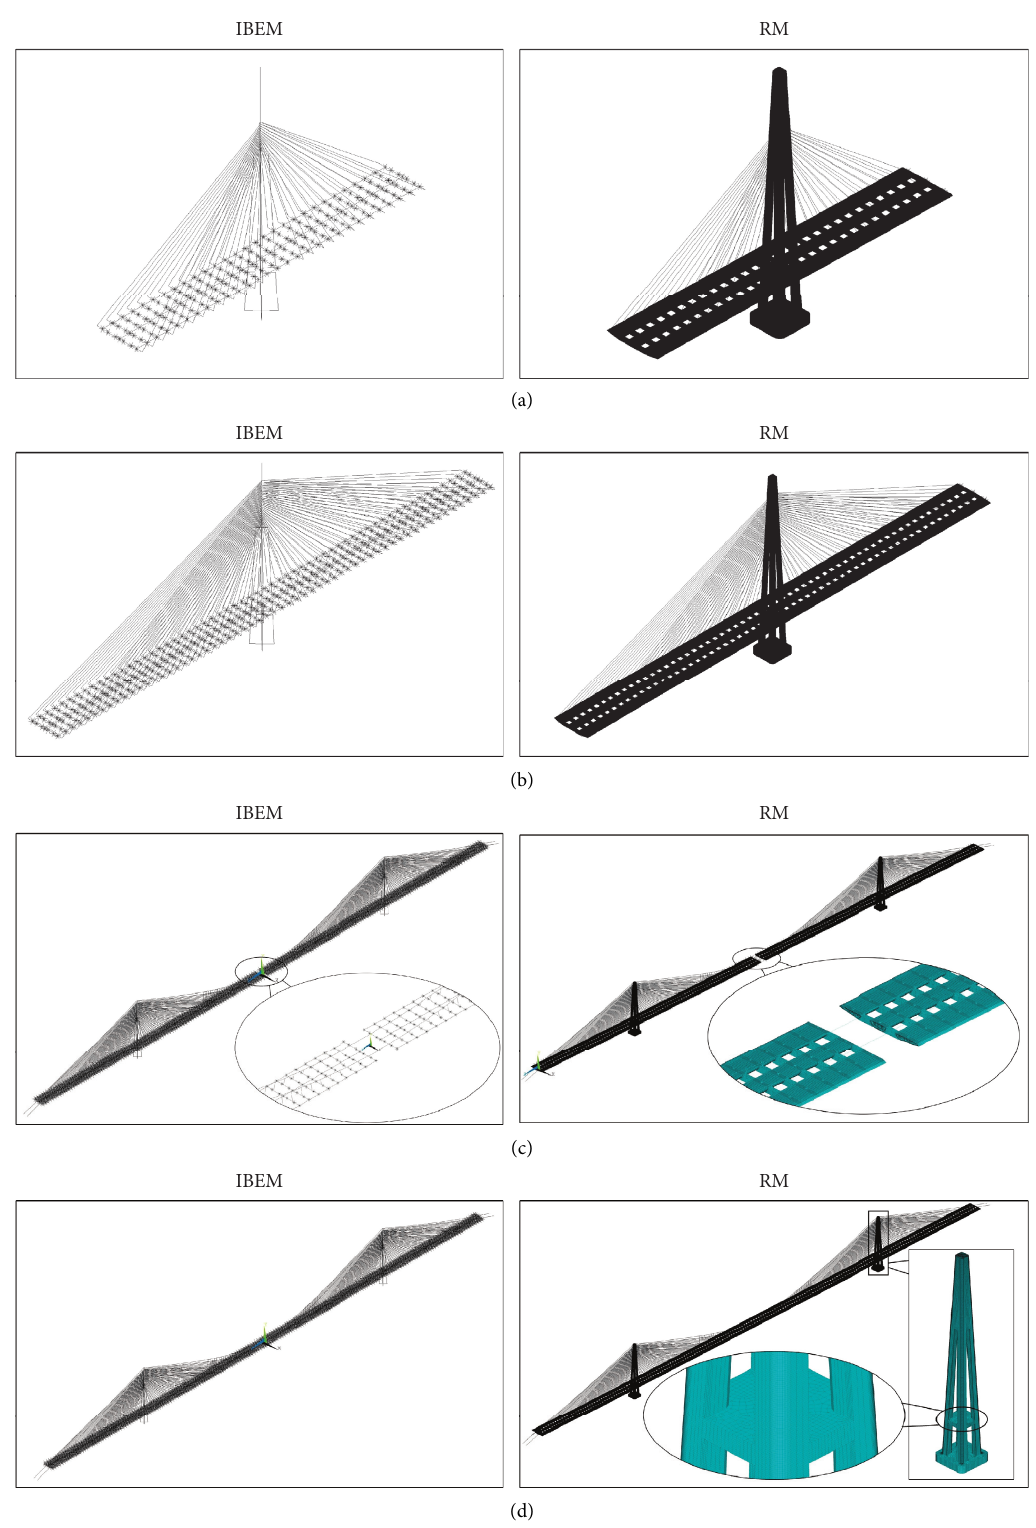
Figure 4: Finite element models in different stages. (a) The common double-cantilever state. (b) The longest double-cantilever state. (c) The preclosure states. (d) The finished